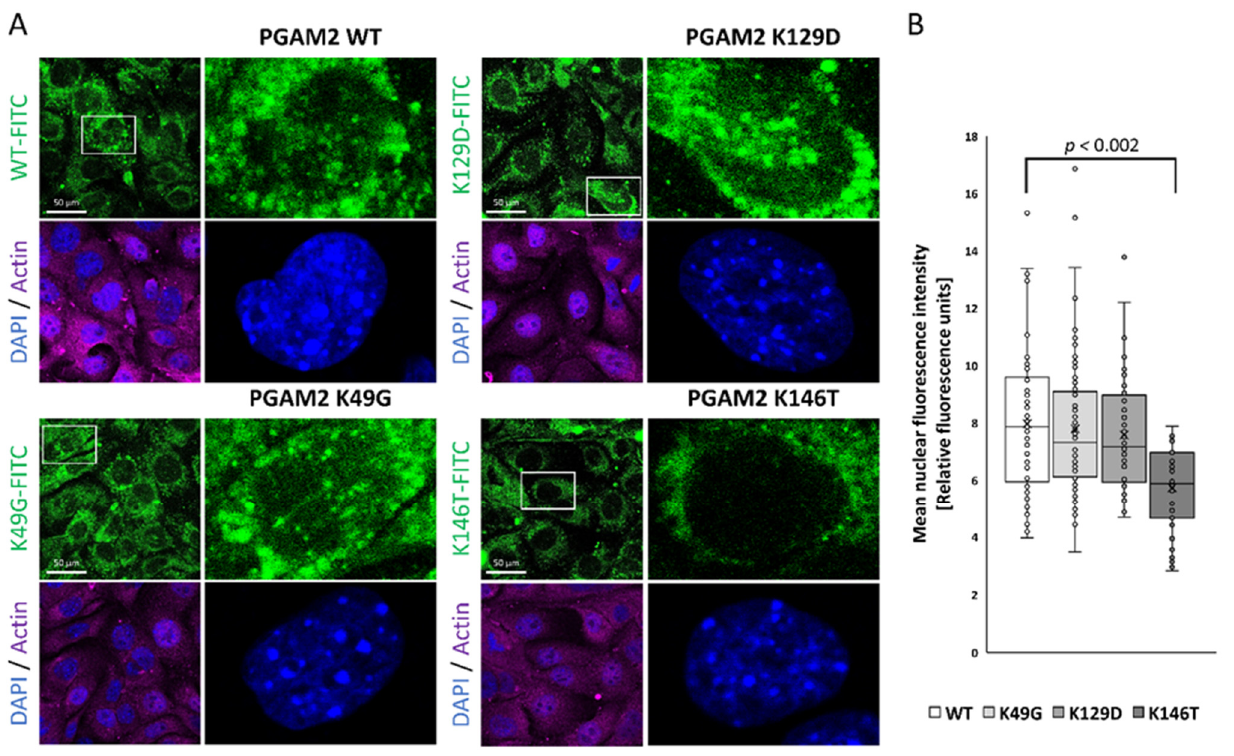
Figure 4. The nuclear import of PGAM2 depends on the lysine residue 146. ( A ) The fluorescence signal visible in the regions of the nuclei recorded for fluorophore (FITC)-labelled PGAM2 muteins K49G and K129D did not differ from that observed in WT-transfected cells. Only the mutein K146T-related fluorescence was significantly lower than that observed in WT-transfected cells. ( B ) Quantification of labelled PGAM2-related fluorescence from the regions of the nuclei.